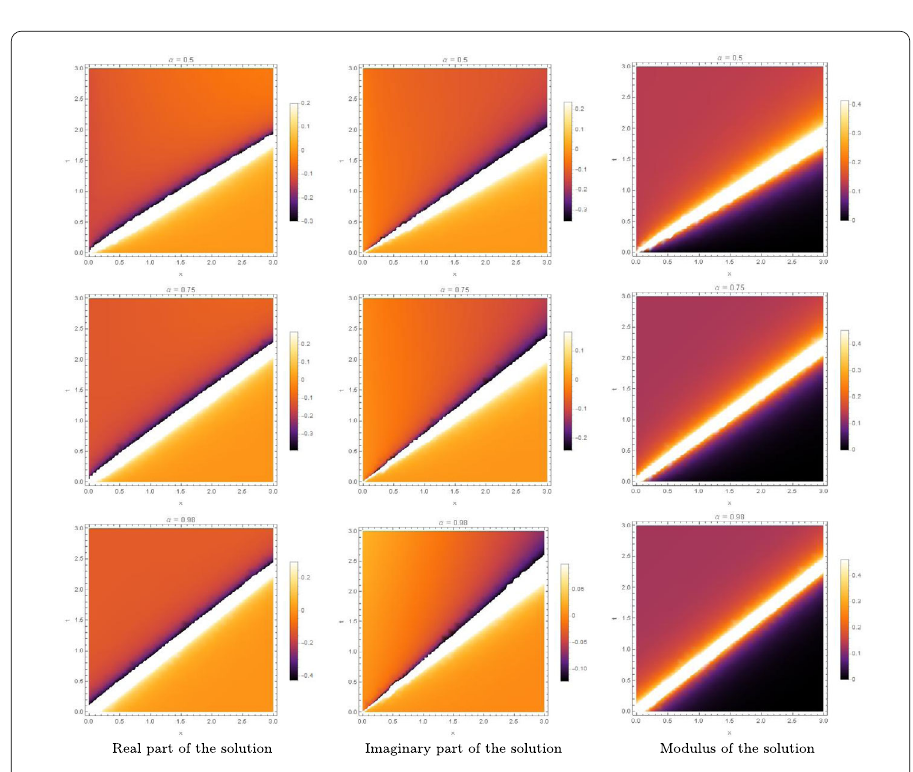
Figure 6 Dynamic behavior of U 12 ( x , t )